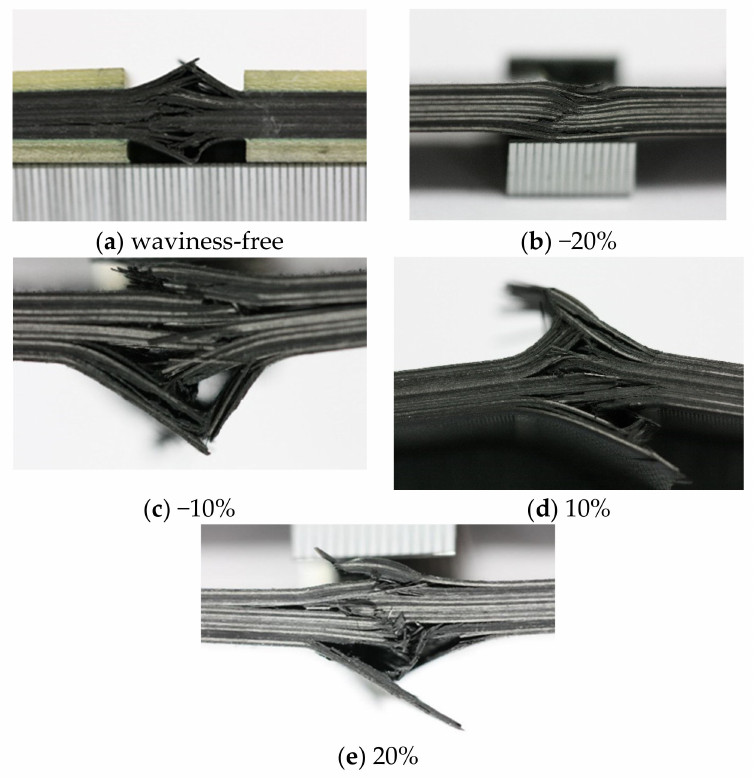
Figure 5. Final state of the failed specimens with different fiber waviness ratios: ( a ) waviness-free, ( b ) − 20%, ( c ) − 10%, ( d ) 10%, ( e )